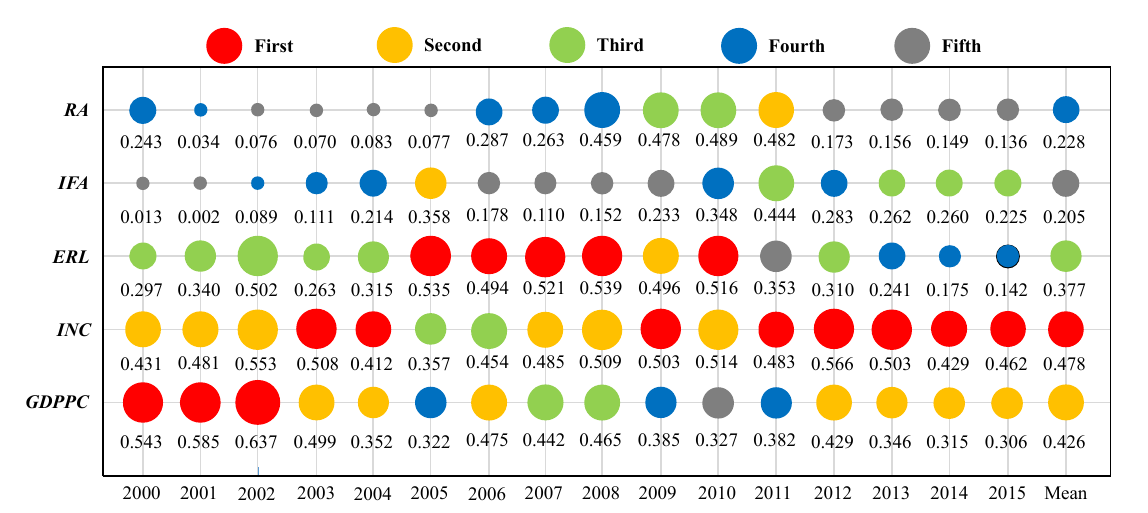
Figure 4. Power of determinant value ( q ) of each driving factor from 2000 to 2015. RA —energy man- agement level, IFA —energy investment level, ERL —education level of rural residents, INC —income level of rural residents, GDPPC —economic development level. Note: colors indicate the rank of the factor force, and the circle size indicates the level of influence of the factor force.